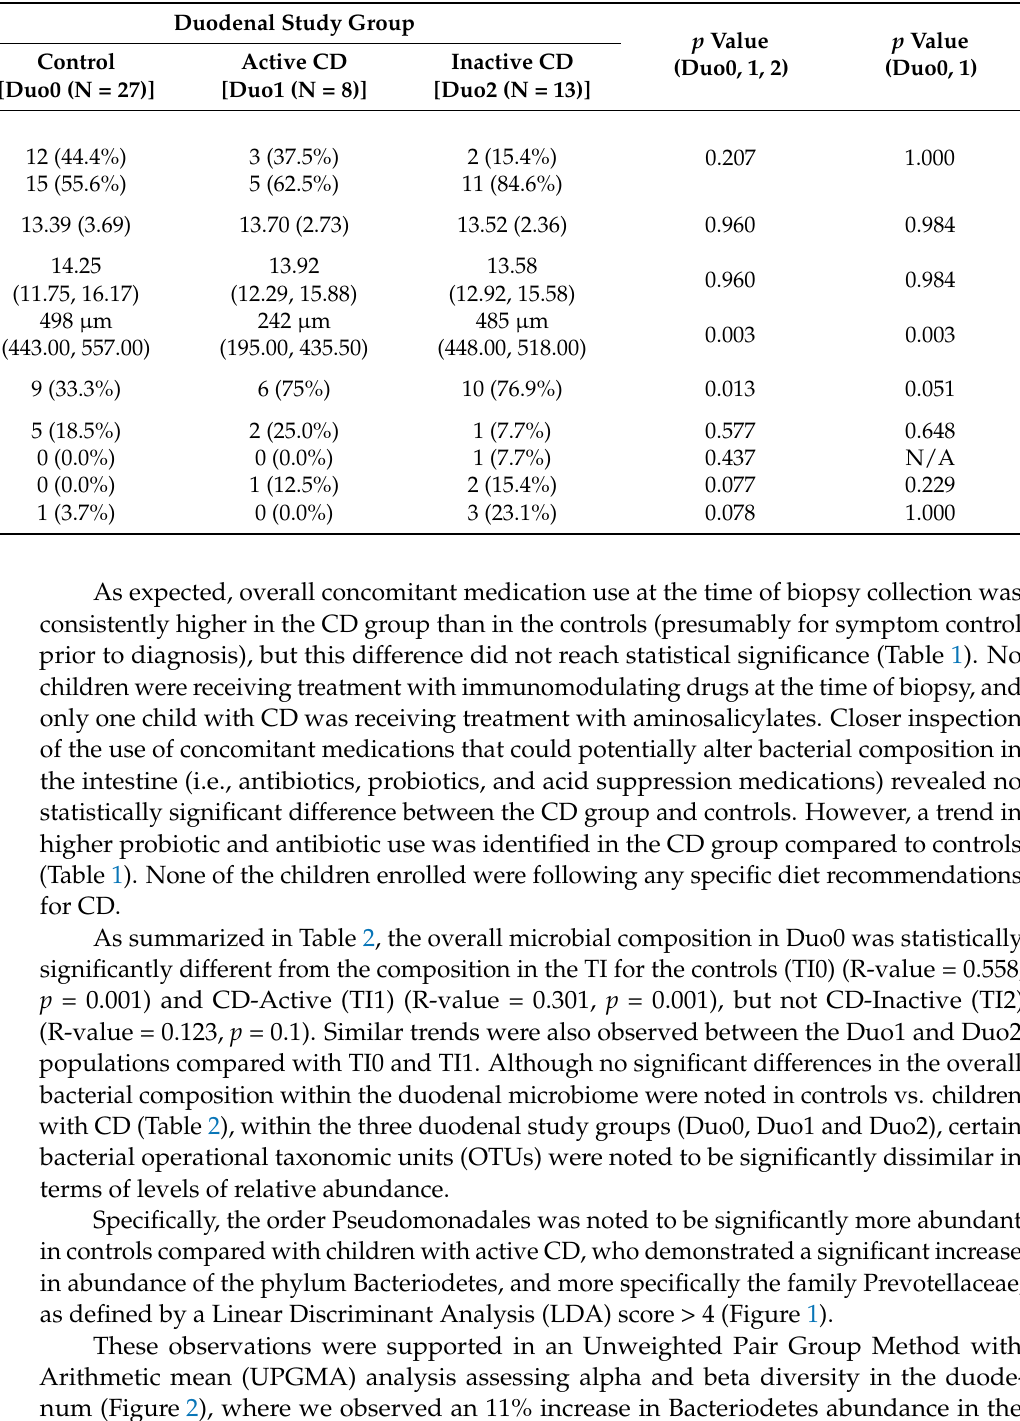
Table 1. Baseline characteristics of children with and without Crohn’s Disease (CD) in the duodenum. This study population was comprised of three subgroups based on disease activity: Control (no CD; Duo0), CD-active (active disease in the duodenum; Duo1), CD-inactive (diagnosis of CD without active disease in the duodenum; Duo2). SD—standard deviation; IQR—interquartile range; NA—not